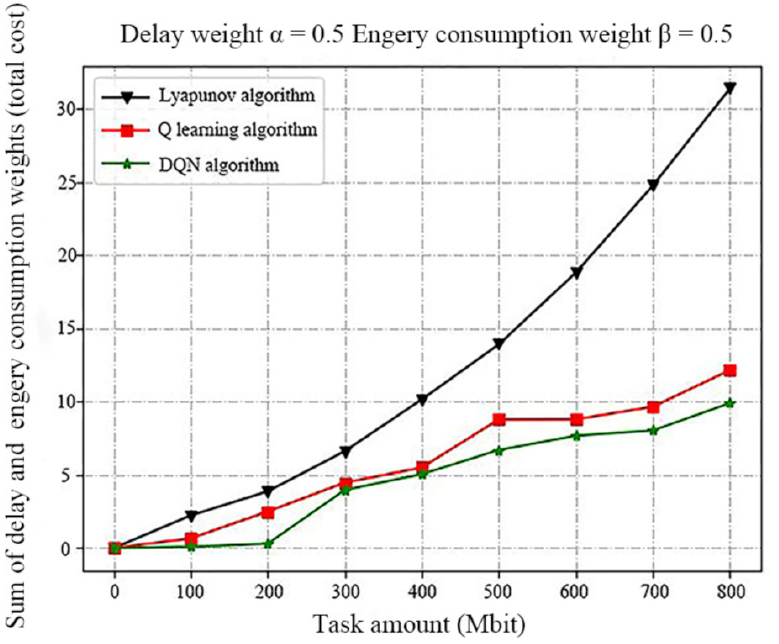
Figure 5. Comparison of total cost of delay and energy consumption weight at 0.5. Black indicates the computation offloading method based on Lyapunov algorithm, red indicates the computation offloading method based on classical Q-learning algorithm, and green indicates the computation offloading method of DQN algorithm proposed in this paper, comparing the cost of the three approaches when the delay and energy consumption are equally important.